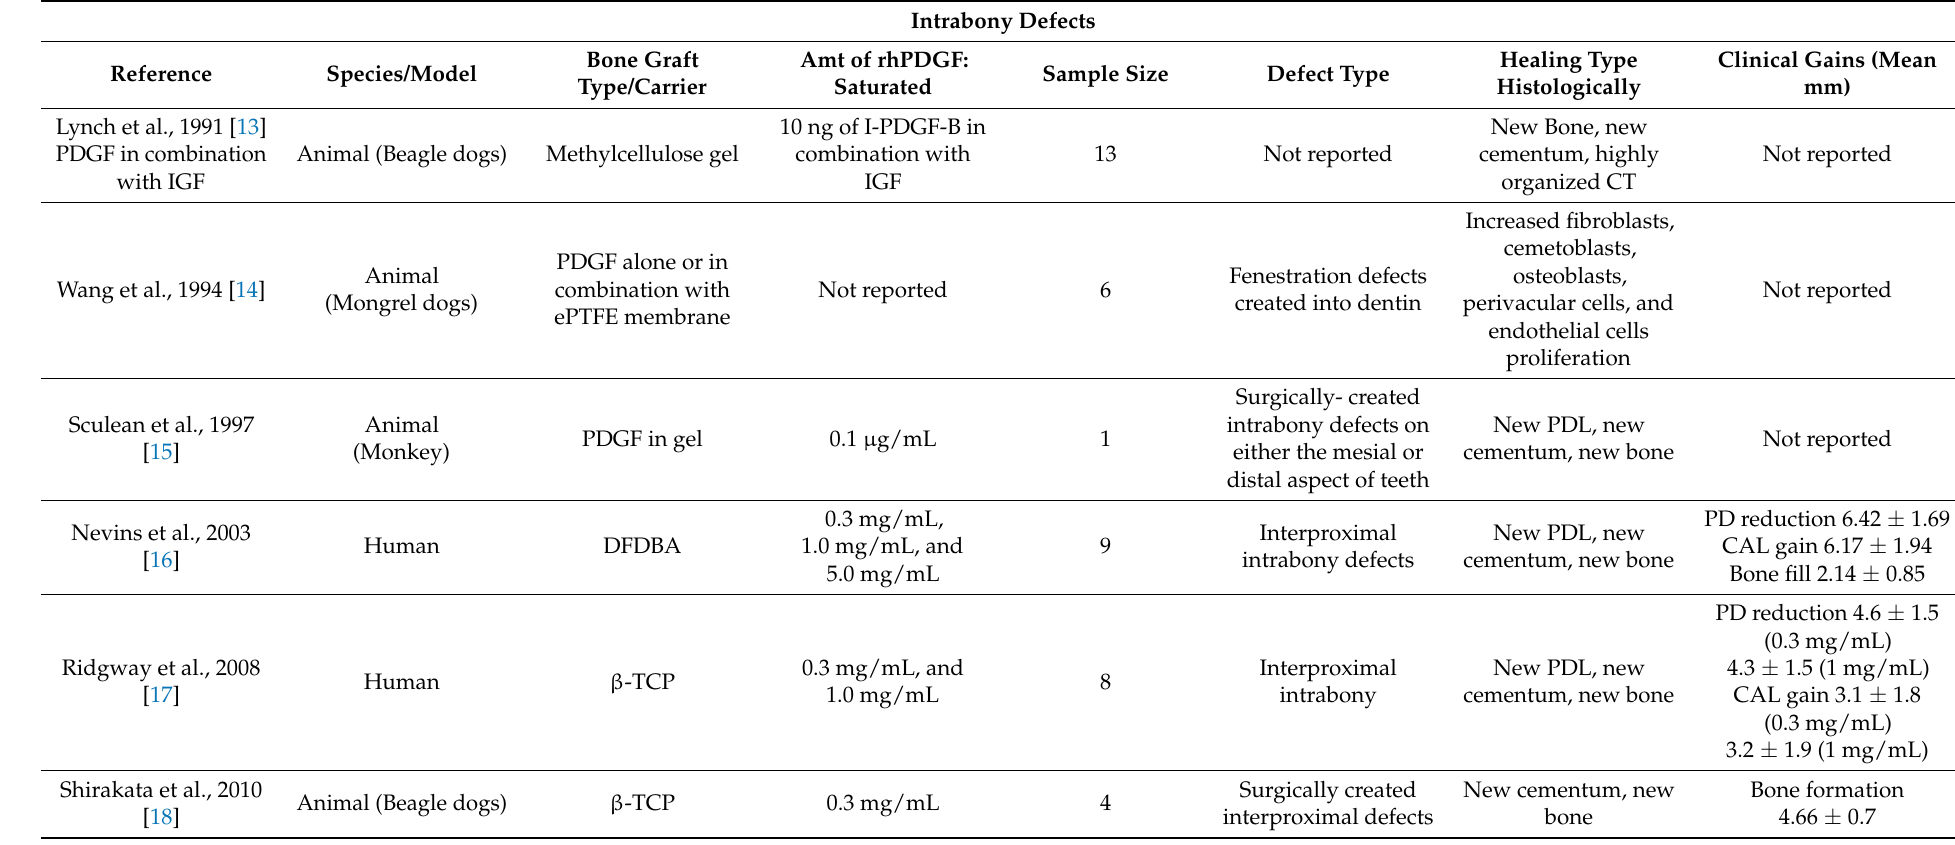
Table 1. Summary of the studies included in this